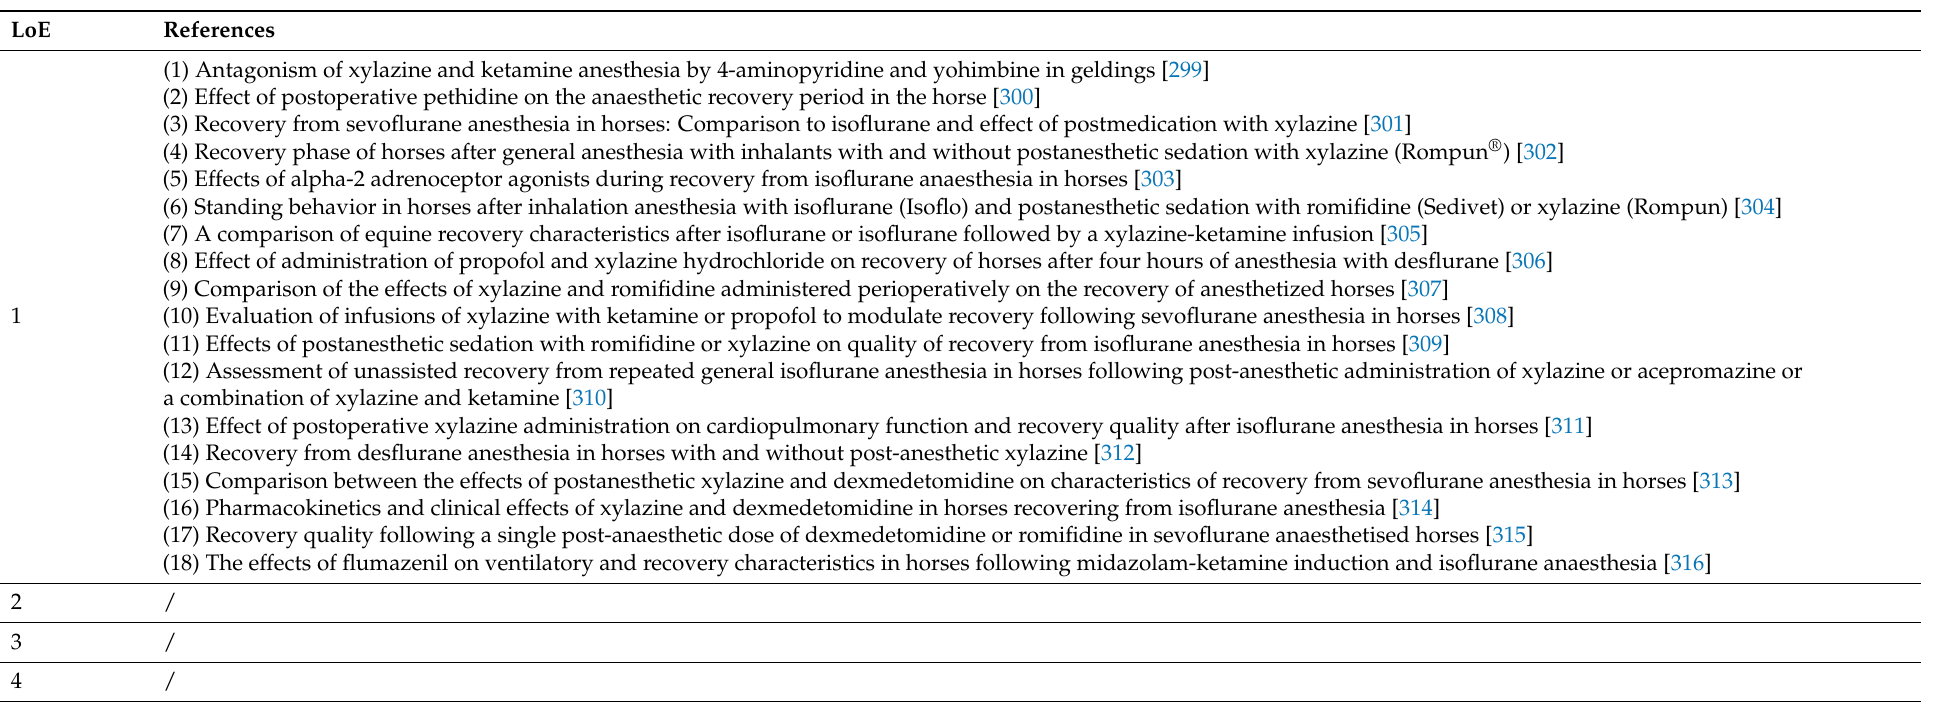
Table 8. Total of publications giving information about “ drugs before/during recovery